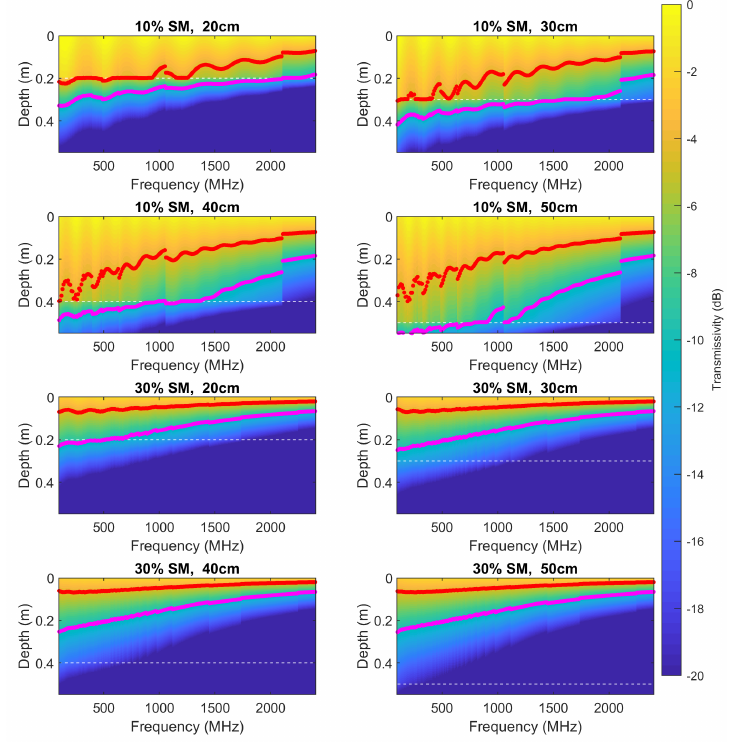
Figure 6. Frequency sweep of four two-layer profiles. The white lines represent the location of the second layer, the red line represent the penetration depth of the configuration, and the magenta line depicts where the transmittance reaches 10% of its original energy. The first slab SM is 10% for the upper four subplots and 30% for the lower four subplots. The second slab SM is 50% for all